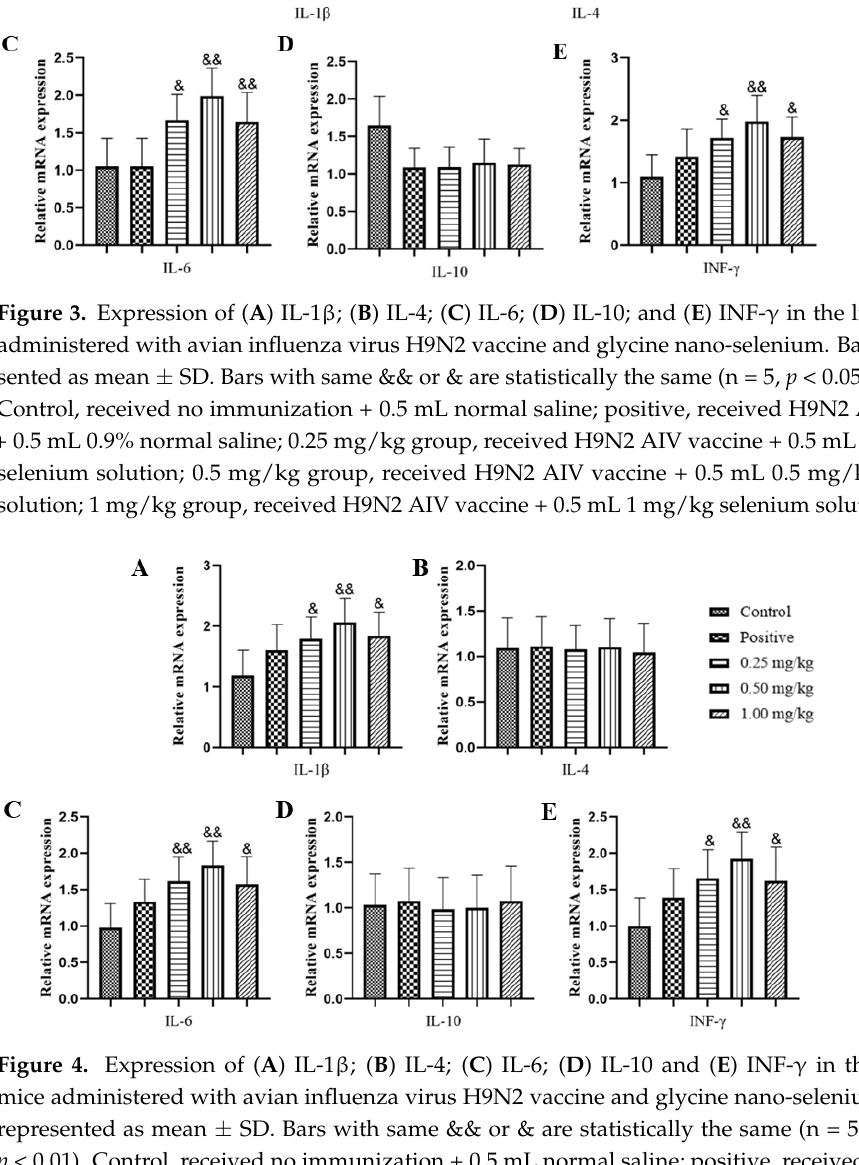
Figure 4. Expression of ( A ) IL-1 β ; ( B ) IL-4; ( C ) IL-6; ( D ) IL-10 and ( E ) INF- γ in the spleen of mice administered with avian influenza virus H9N2 vaccine and glycine nano-selenium. Bars are represented as mean ± SD. Bars with same && or & are statistically the same (n = 5, p < 0.05 or p < 0.01). Control, received no immunization + 0.5 mL normal saline; positive, received H9N2 AIV vaccine + 0.5 mL 0.9% normal saline; 0.25 mg/kg group, received H9N2 AIV vaccine + 0.5 mL 0.25 mg/kg selenium solution; 0.5 mg/kg group, received H9N2 AIV vaccine + 0.5 mL 0.5 mg/kg selenium solution; 1 mg/kg group, received H9N2 AIV vaccine + 0.5 mL 1 mg/kg selenium solution.